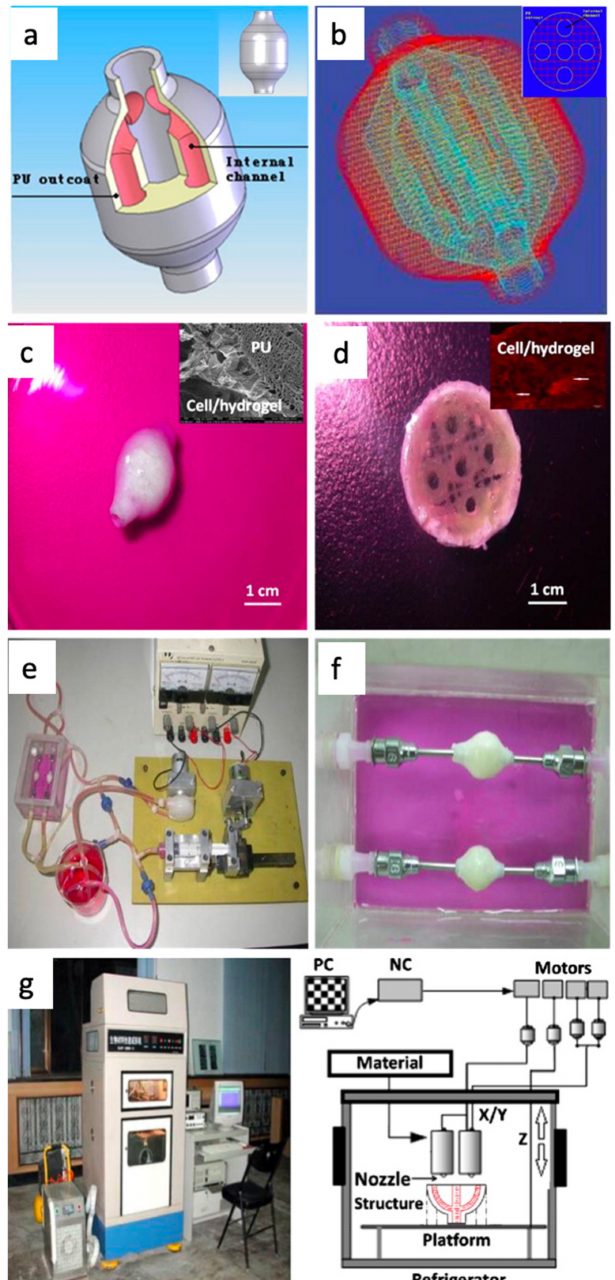
Figure 14. A sizable scaled-up 3DP-driven complex organ with vascularized liver tissue construct using a double-nozzle 3PD set-up built in Tsinghua University, Prof. Wang’s laboratory. Representation of the hybrid hierarchical construct fabricated via a DLDM RP system: ( a ) a digital CAD model with an outlook (the inset image) and an internal branched network; ( b ) a common layer interface (CLI) file and a cross-sectional vision (the inset image) of the CAD model; ( c ) a DLDM product with a PU outcoat; the inset image displays the SEM result of the in vitro cultured sample with porous PU and cell/hydrogel layers; ( d ) the middle part of ( c ) with branched/grid internal cell/hydrogel channels; the inset image displays the PI staining result of the cell/hydrogel section; ( e ) two complex constructs undergoing in vitro pulsatile culture; ( f ) a magnified view of ( e ); ( g ) the DLDM RP device and a schematic design of the printing processes; cells were loaded in the natural gelatin/alginate/fibrinogen hydrogel and deposited with one nozzle while synthetic PU was added with another nozzle. Images reproduced with permission from reference [106], Copyright 2013, with permission from